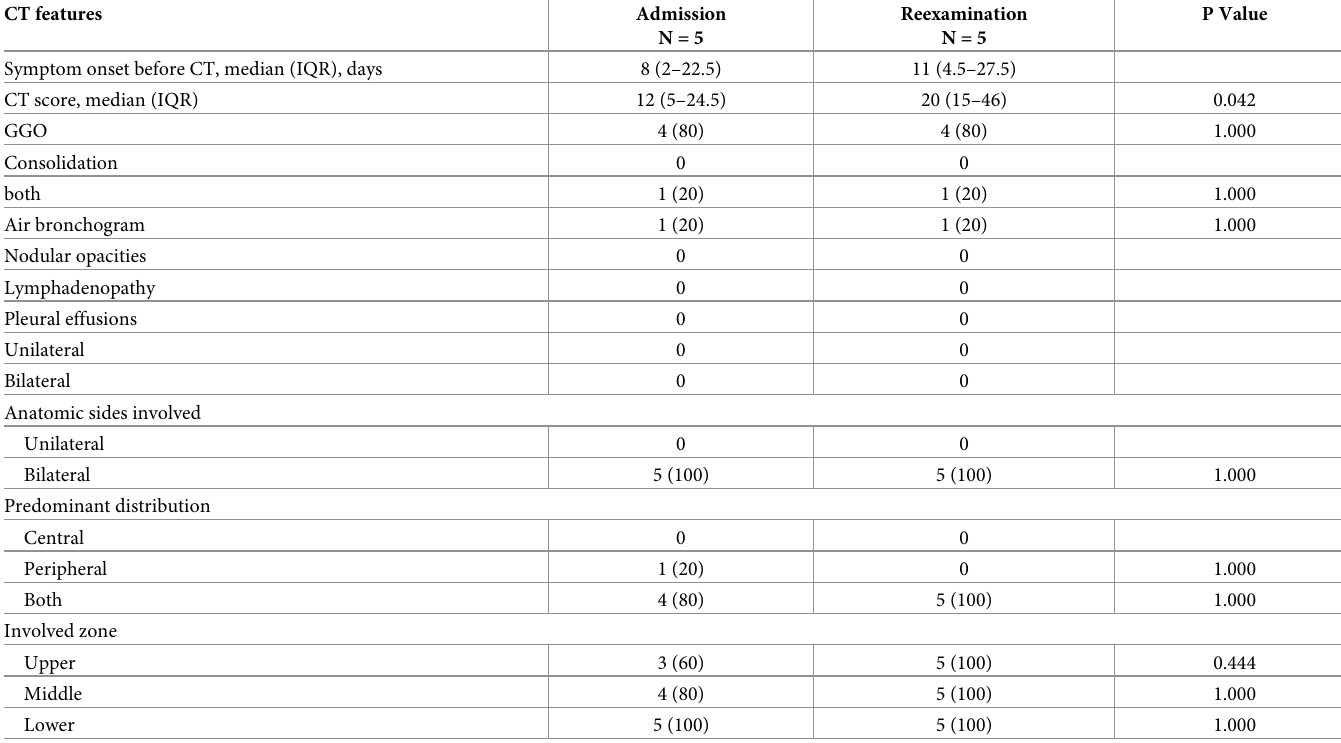
Table 4. Comparison of CT features in mortality group between admission and reexamination. CT